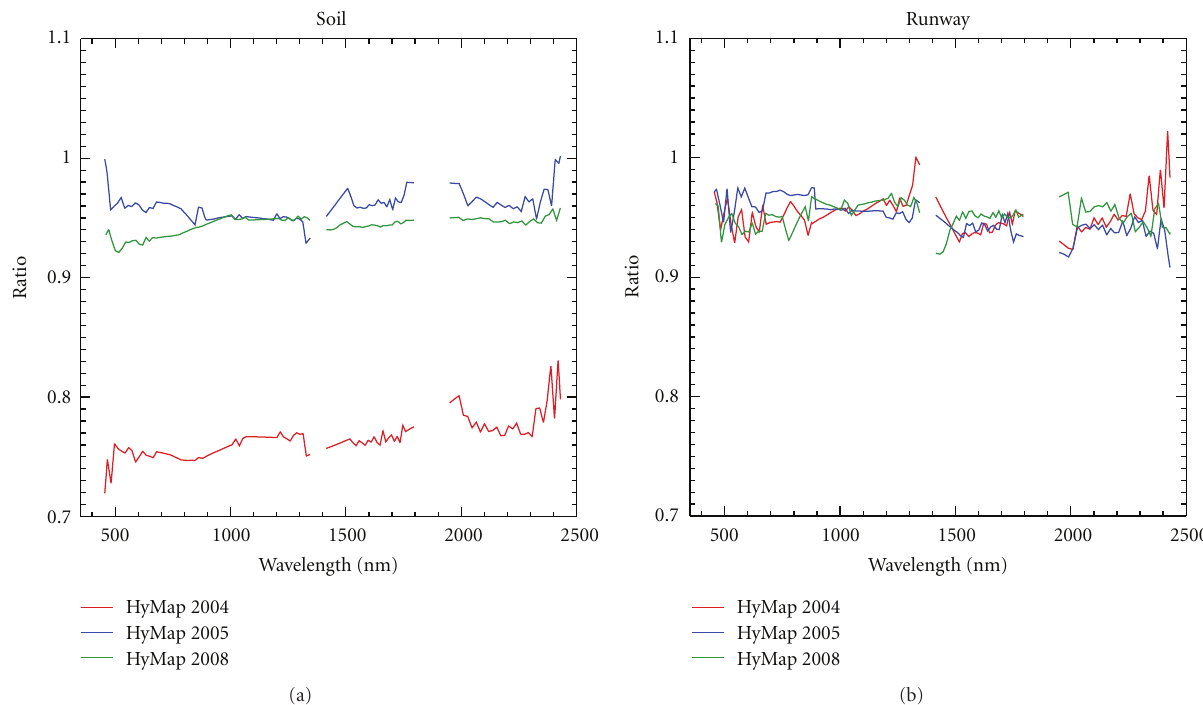
Figure 5: Ratio of spectra of identical image pixels (within the given geometric accuracy) in the overlap of neighboring scenes for a former runway and a soil